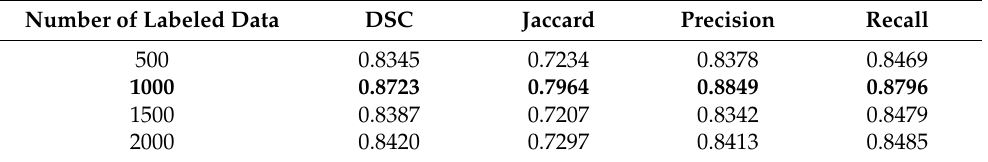
Table 2. Segmentation performance of CAFS for nasopharyngeal carcinoma when different amounts of labeled data are provided for model training. The four metrics of DSC, Jaccard, precision, and recall were used to evaluate the performance of the segmentation. The highest value of each metric is bolded in the table. The data show that the best training results are achieved when 1000 labeled samples are provided for the training